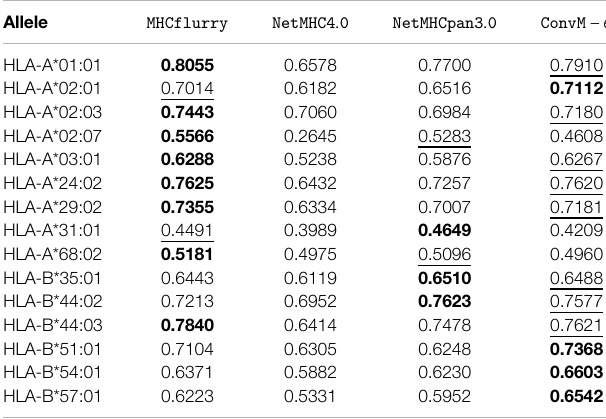
TABLE 7 | Performance comparison over mass spectrometry dataset in PPV